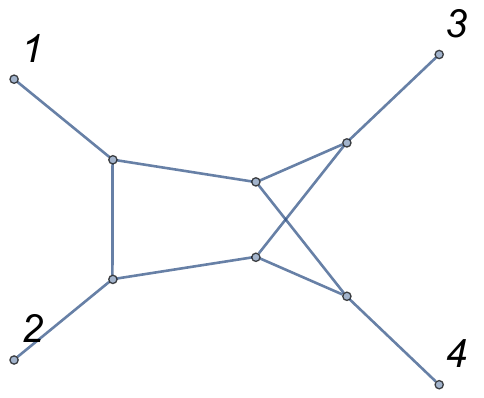
Figure 12 . The nonplanar double box with four external lines.